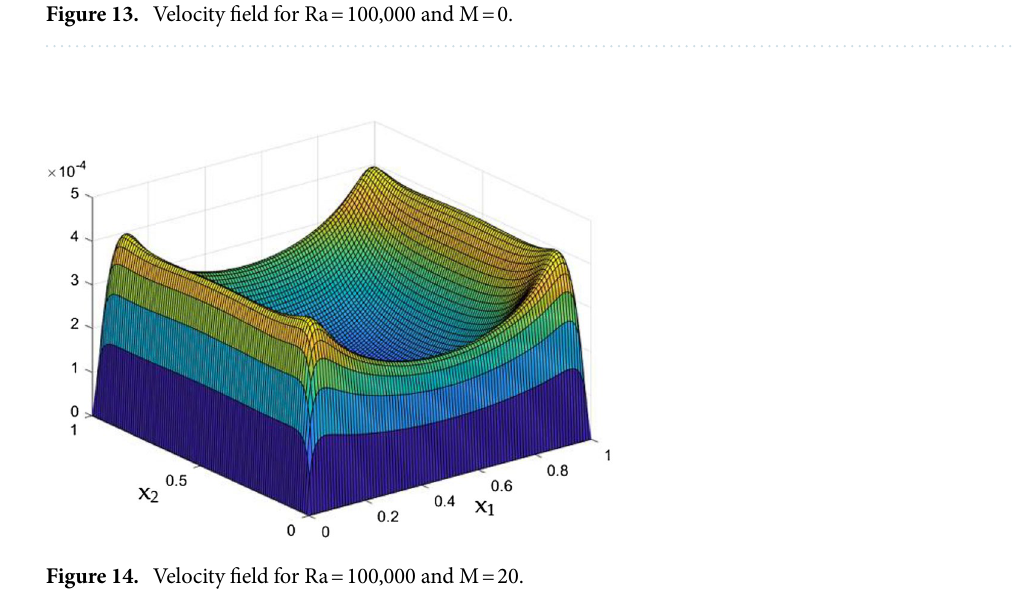
Figure 13. Velocity field for Ra = 100,000 and M = 0.